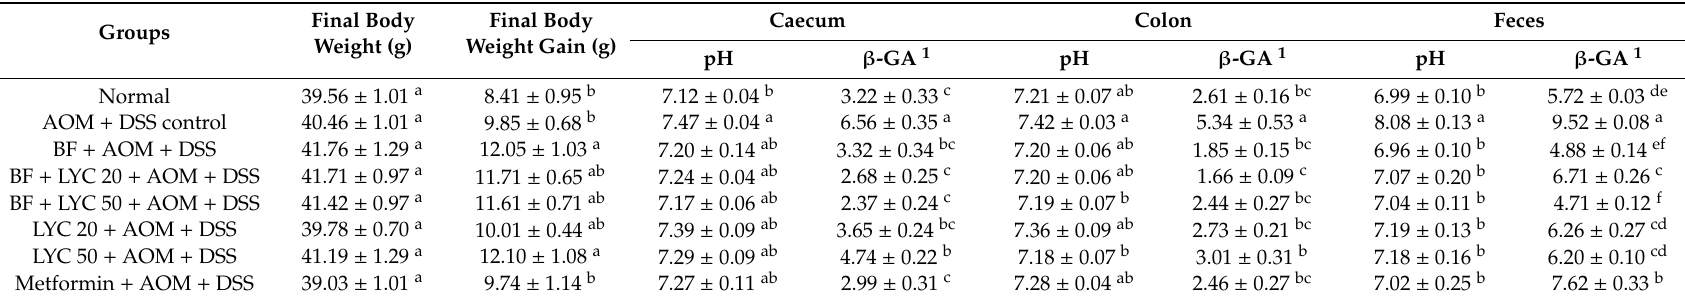
Table 1. Final body weight, final body weight gain, pH and β -glucuronidase ( β -GA) in the caecum, colon, and feces content at week 16 of the